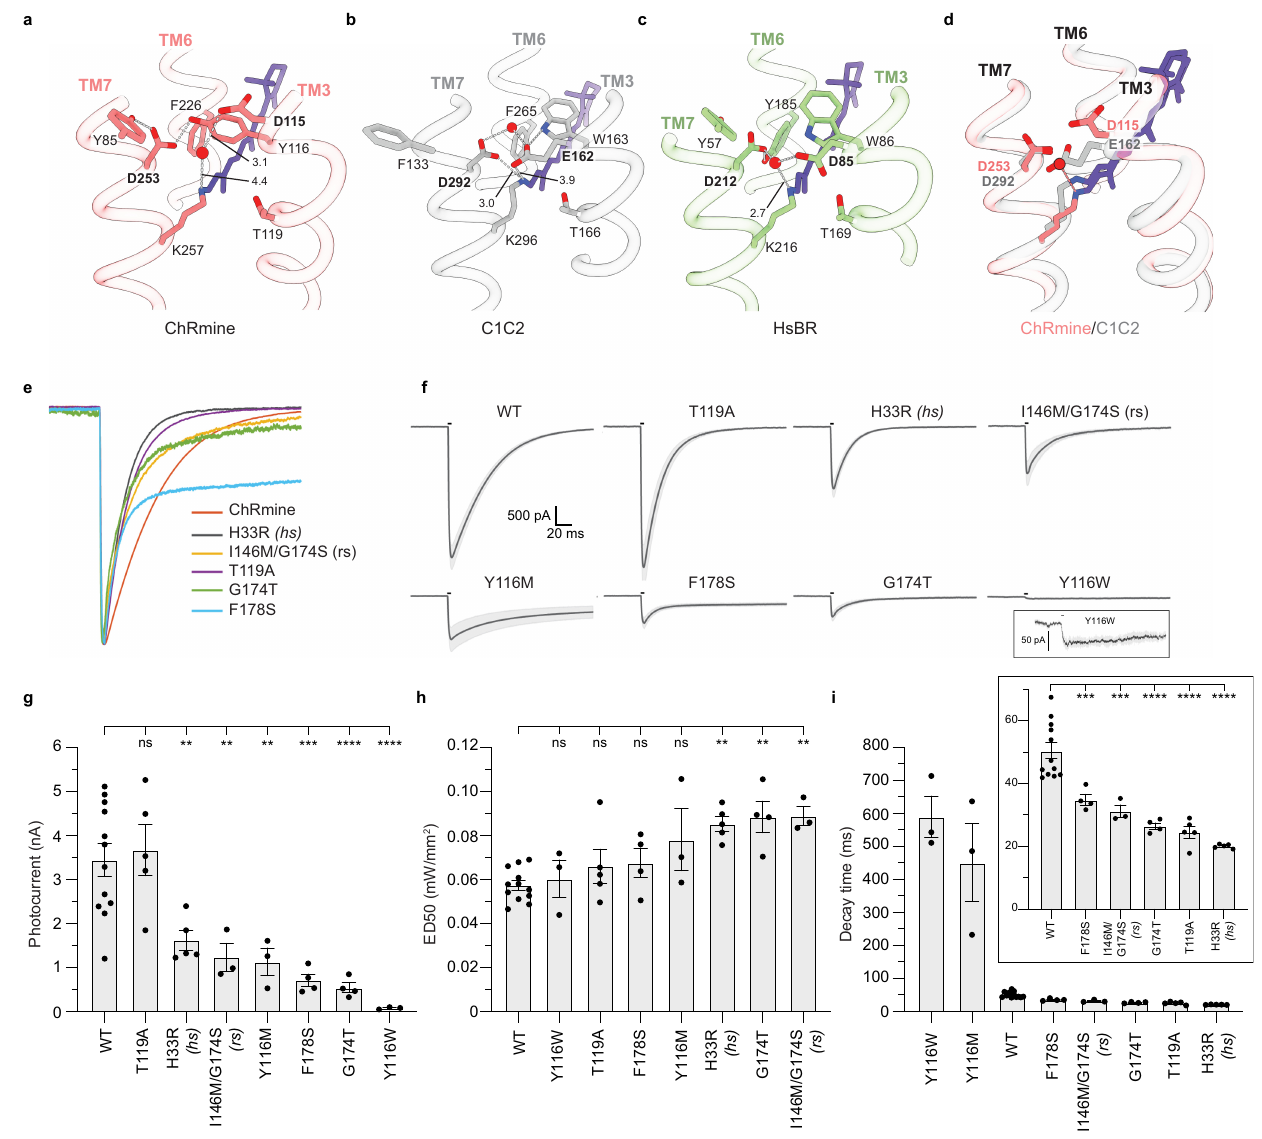
Fig. 4 | Schiff base chemistry and function of ChRmine variants. Views of the area around the protonated Schiff base in a ChRmine, ( b ) C1C2, ( c ) HsBr, and d ChRmine and C1C2 overlaid. Negatively charged counterions and proton acceptors, interacting residues, and key water molecules are indicated. e Peak- normalized currents for ChRmine and fi ve mutants with faster closing rate. Note long-lived F178S steady-state current. f Average photocurrents for ChRmine and eachmutantevaluated.Thebaraboveeachtraceindicatesa5mslightpulse.Y116W is shown in inset with ten-fold expanded current scale. g Peak photocurrents, ( h ) lightsensitivity,and i decaytimeconstantforeachchannel.Valuesaremean±sem